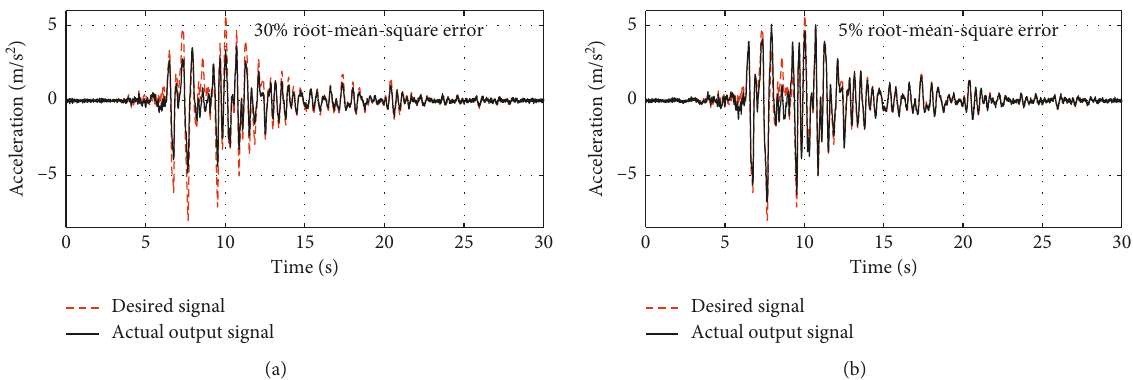
Figure 6: Comparison of the output signal and desired signal of Kobe earthquake with 0.8g PGA. (a) Output without iteration; (b) output with 4 iterations.